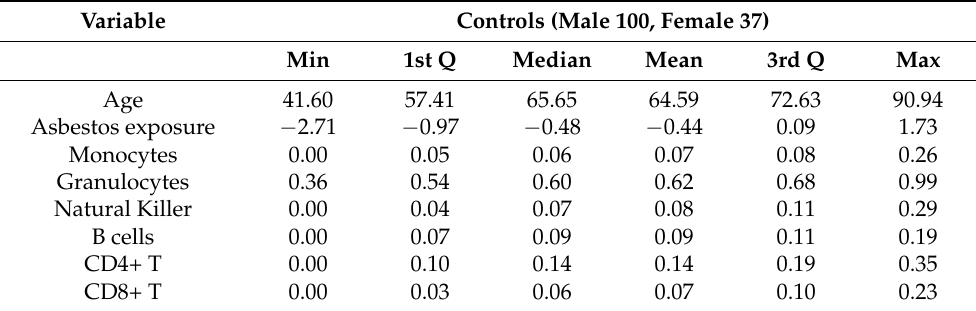
Table 4. Descriptive characteristics of cancer-free control group.